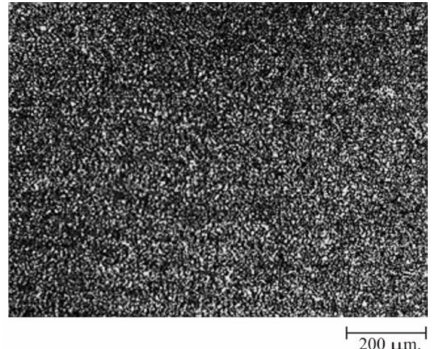
Figure 20. Fine-grained structure of HAZ, etch.